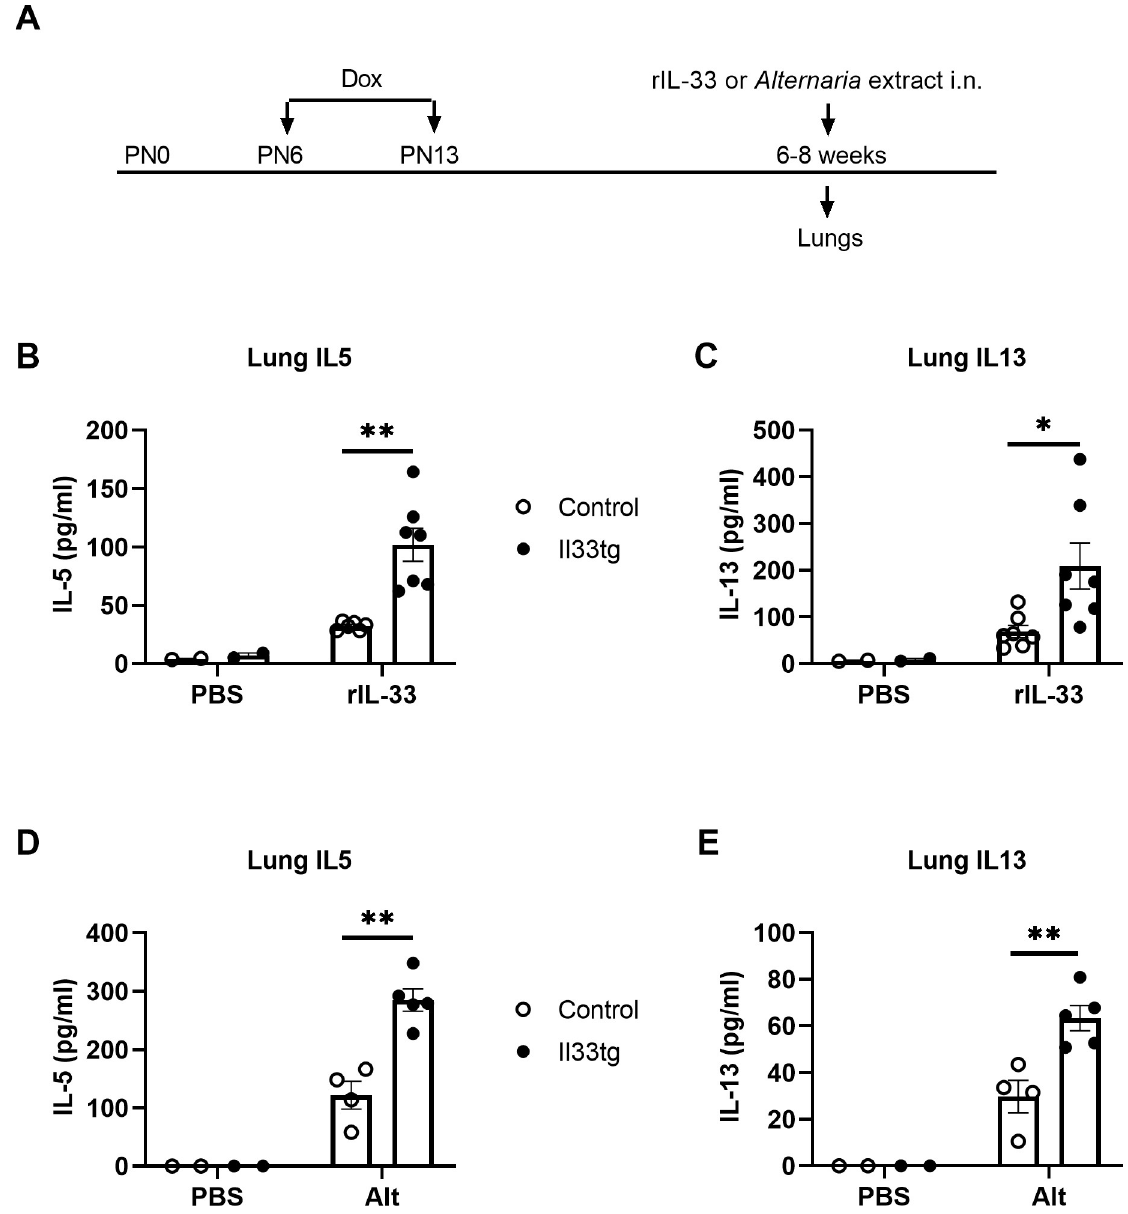
Fig 2. Neonatal-IL-33-experienced mice had enhanced innate type 2 immune responses later in life. (A) Mouse experimental protocol. Mice were provided with Dox water on postnatal days 6–13. After resting for 4–6 weeks, CCSP-Il33tg mice or control mice were i.n. exposed to either recombinant IL-33 (100 ng/mouse) or Alt extract (50 μ g/mouse). Lung cytokines in these mice were analyzed after 4.5 hours. (B, C) Lung IL-5 and IL-13 levels after PBS or IL-33 exposure. (D, E) Lung IL-5 and IL-13 levels after PBS or Alt exposure. Data are presented as means + SEMs (n = 2 mice per group for PBS exposure; n = 4–5 mice per group for IL-33 or Alt exposure). � p < 0.05, �� p < 0.01 between the groups, indicated by horizontal line. Data are representative of two ( Alt exposure) or three (IL-33 exposure) independent